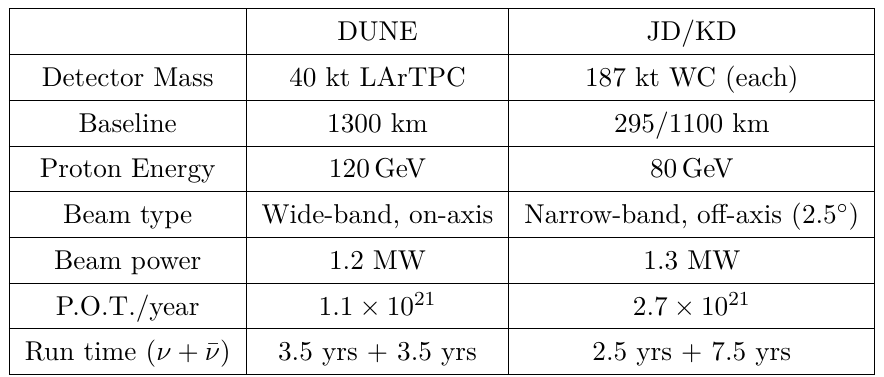
Table 3 . Essential features of DUNE [27] and JD/KD [31] experiments used in our